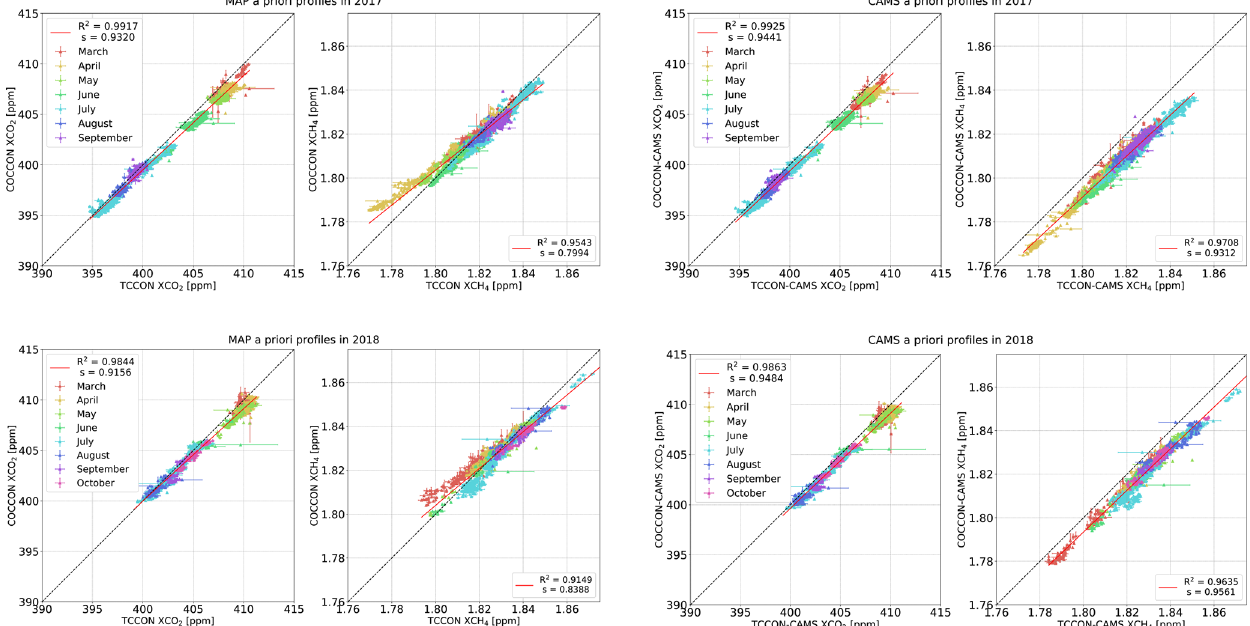
Figure 5. Comparisons of COCCON and TCCON data in 2017 and 2018 using MAP (four left panels) and CAMS (four right panels) profiles as a prior profiles. The slope of the relationship is represented by “s” in the figure, and the coefficient of determination is represented by “ R 2 ”. Each point represents a 10min average of coincident measurements between COCCON and TCCON. The red solid line represents the best fit line, and the black dashed line is the one-to-one